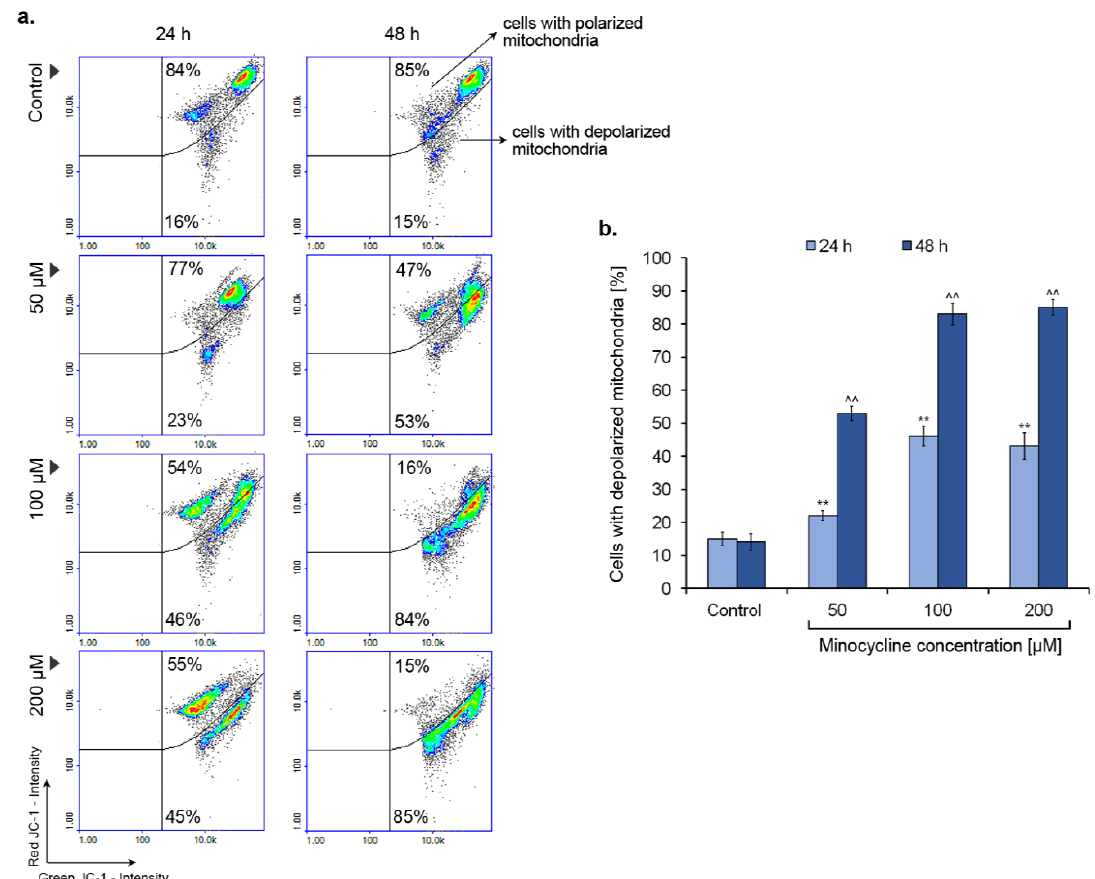
Figure 9. Minocycline decreases mitochondrial membrane potential in human melanoma cells after 24 h and 48 h incubation. Representative scatter plots display a tested cells population divided by a gate to the subpopulations of polarized and depolarized cells ( a ). Mean values of the percentage of cells with lowered mitochondrial membrane potential are presented in the bar graph ( b ). ** p < 0.005 vs. control 24 h; ^^ p < 0.005 vs. control 48 h.